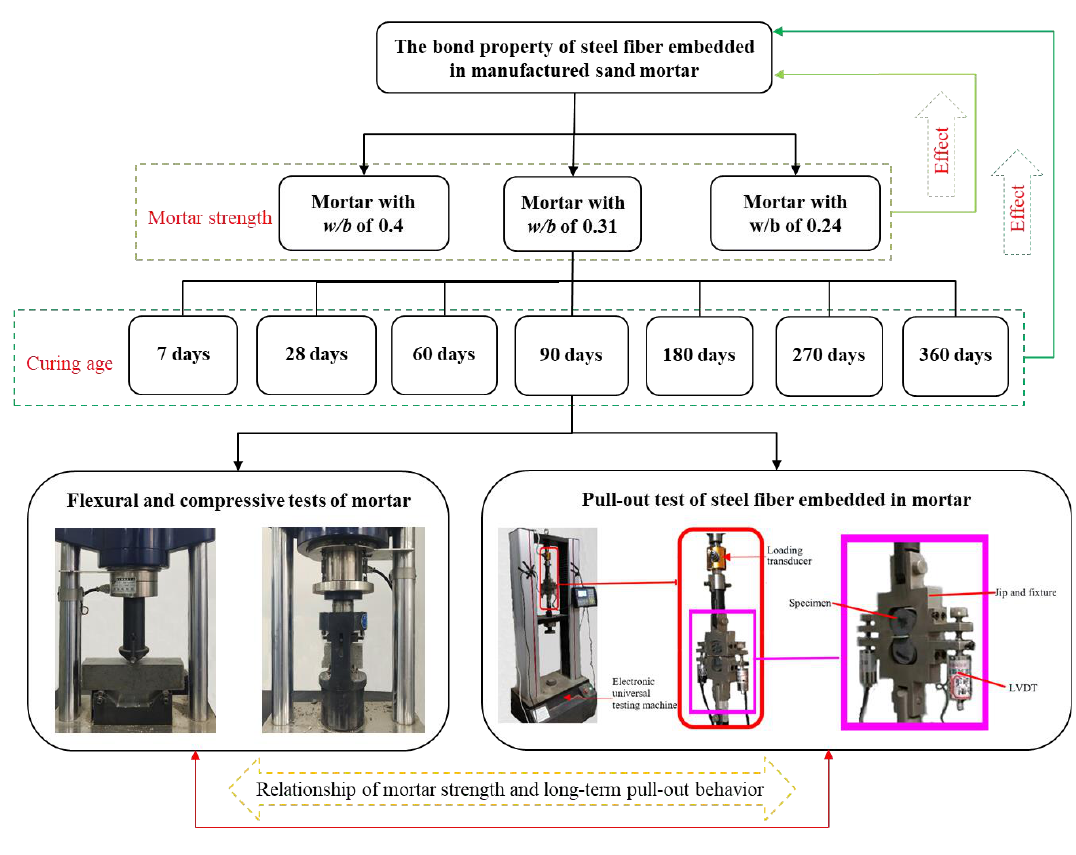
Figure 1. Experimental program.